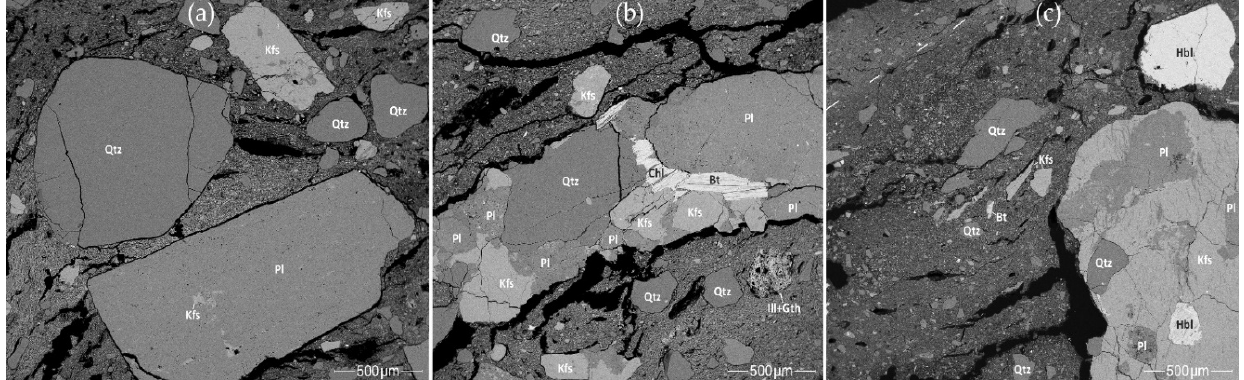
Figure 17. SEM BSE images of the early coarse ceramic pastes with meso-vughs and macro-elongated voids (seen as black areas): ( a ) CW-E_M1 ceramic paste with isolated quartz and feldspar grains; ( b ) HG-E_M5 ceramic paste with a ferruginous nodule (Ill + Gth–goethite enriched illite) and coarse granite fragments; ( c ) HG-E_S3 ceramic paste with granite fragments, a dashed line in the upper left corner indicates the boundary between the main clay matrix and the upper phosphorus-enriched clay layer.